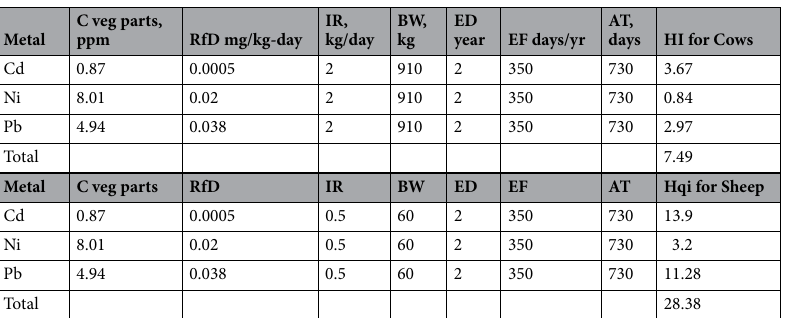
Table 12. Estimation of hazard quotients and health index for carcinogen heavy metal exposure of cows and sheep from ingesting vegetative parts of barley. Data Source: 56–58